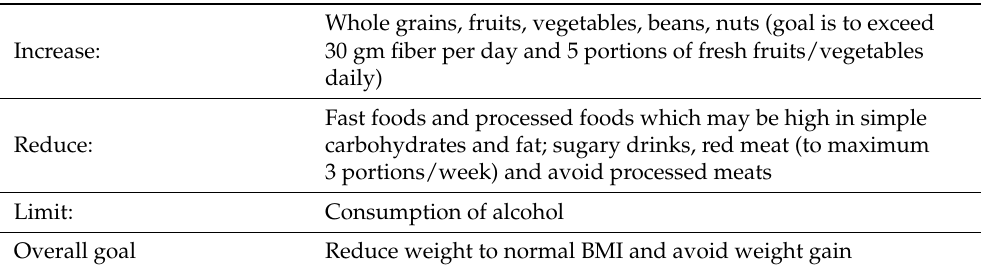
Table 1. Dietary recommendations from the World Cancer Research Fund and the American Institute for Cancer Research